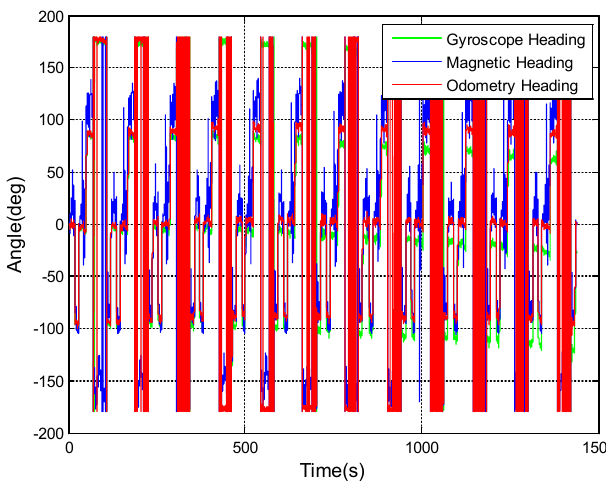
Figure 6. Comparison of heading estimation.